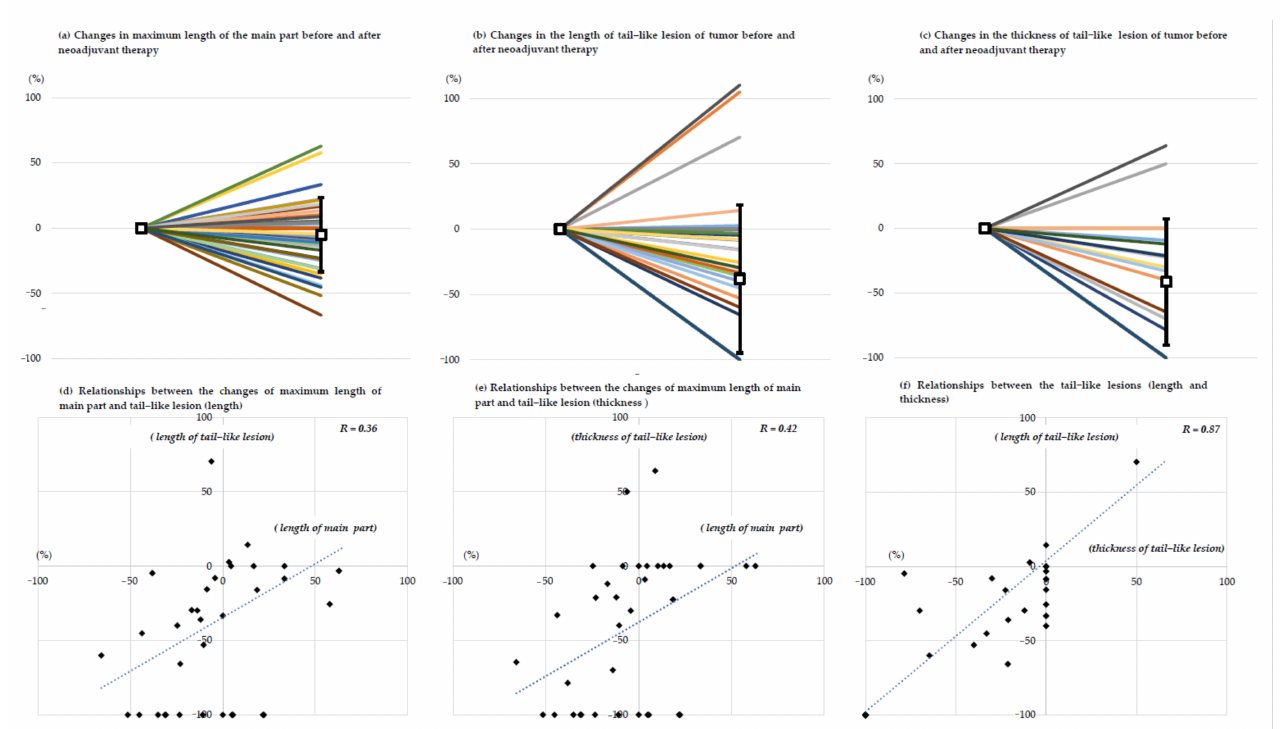
Figure 1. The rates of change in the tumor and the relationship between the main part and tail-like lesion. ( a ) Rates of change in maximum length of the tumor. ( b ) Rates of change in the length of the tail-like lesion. ( c ) Rates of change in the thickness of the tail-like lesion. ( d ) Relationship between the changes in maximum length of the main part and the length of the tail-like lesion. Squares indicate the means, and the error bars indicate the standard deviations. ( e ) Relationship between the rate of change in maximum length of the main part and the thickness of the tail-like lesion. ( f ) Relationship between the tail-like lesions’ length and